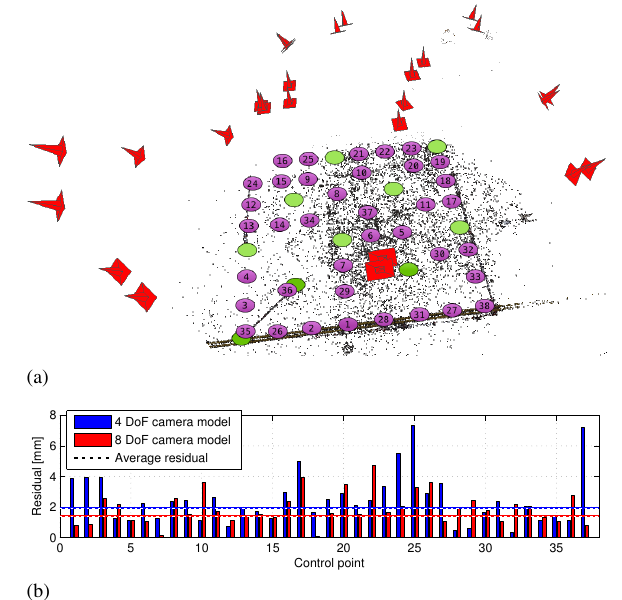
Figure 4: Platform data-set: Camera, point cloud and con- trol point configuration (fixed: green, estimated: purple) (a), and accuracy of control points for different camera models w.r.t. ground-truth data